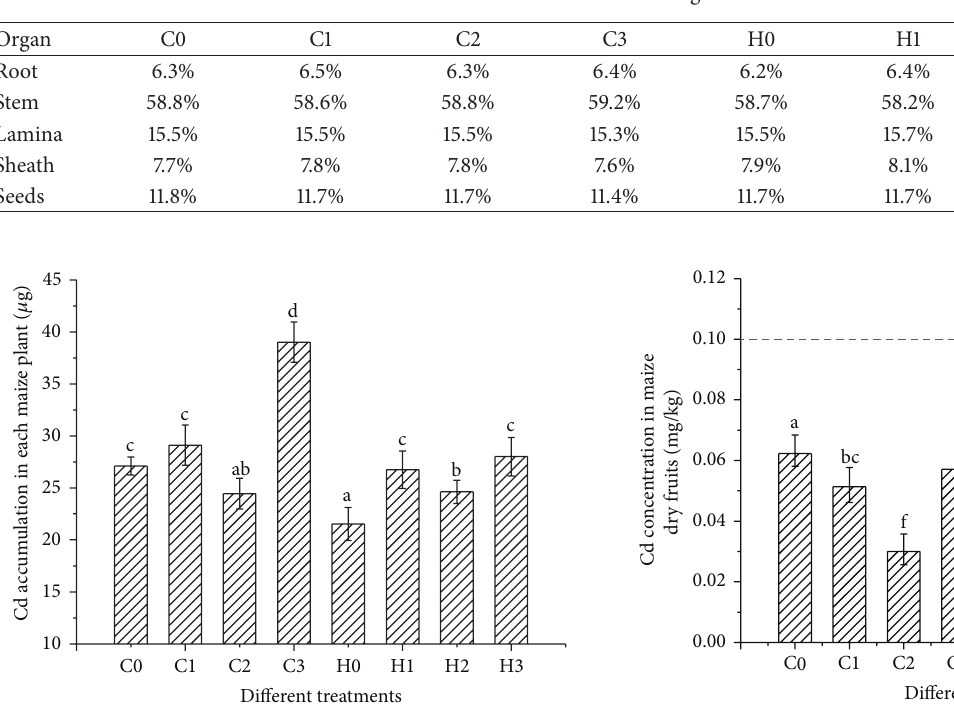
Table 4: The biomass ratio of different maize organs with different treatments.